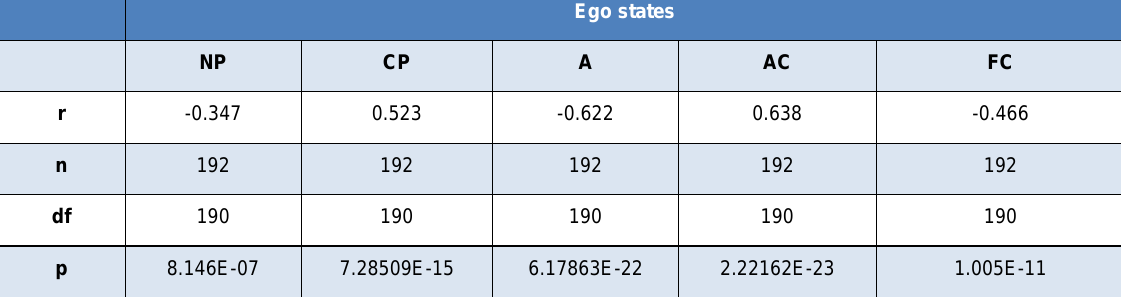
Table 5: Significance testing of r: Ego states and Neuroticism (All respondents)